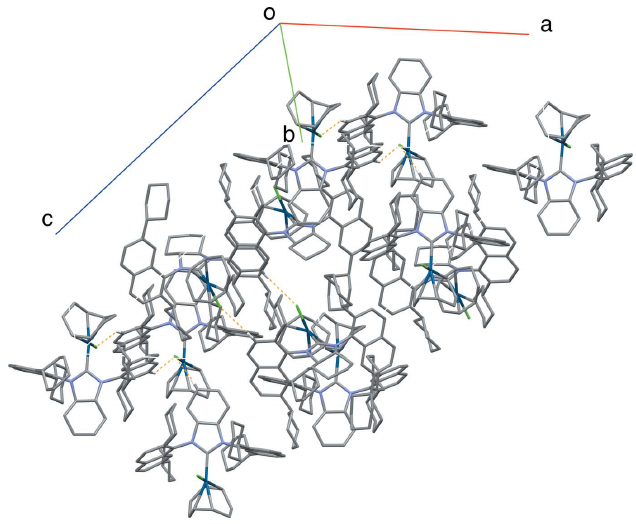
Figure 4 Molecular packing in the crystal of (I) with C—H (cid:2)(cid:2)(cid:2) Cl interactions highlighted in